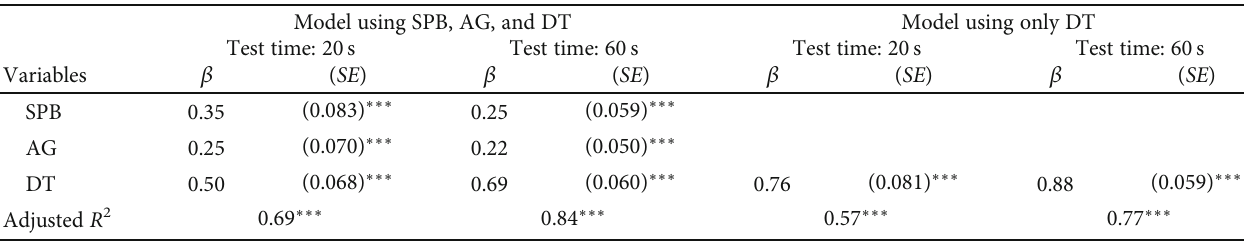
Table 1: Regression analysis